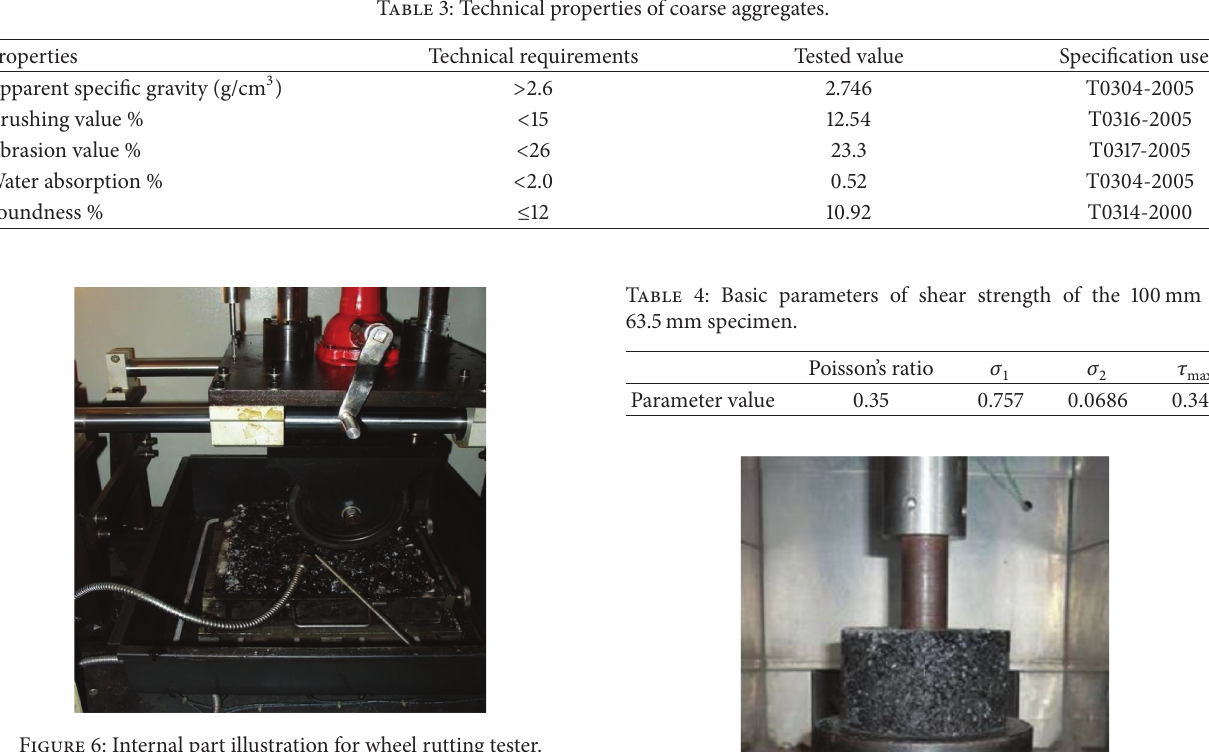
Figure 6: Internal part illustration for wheel rutting tester.